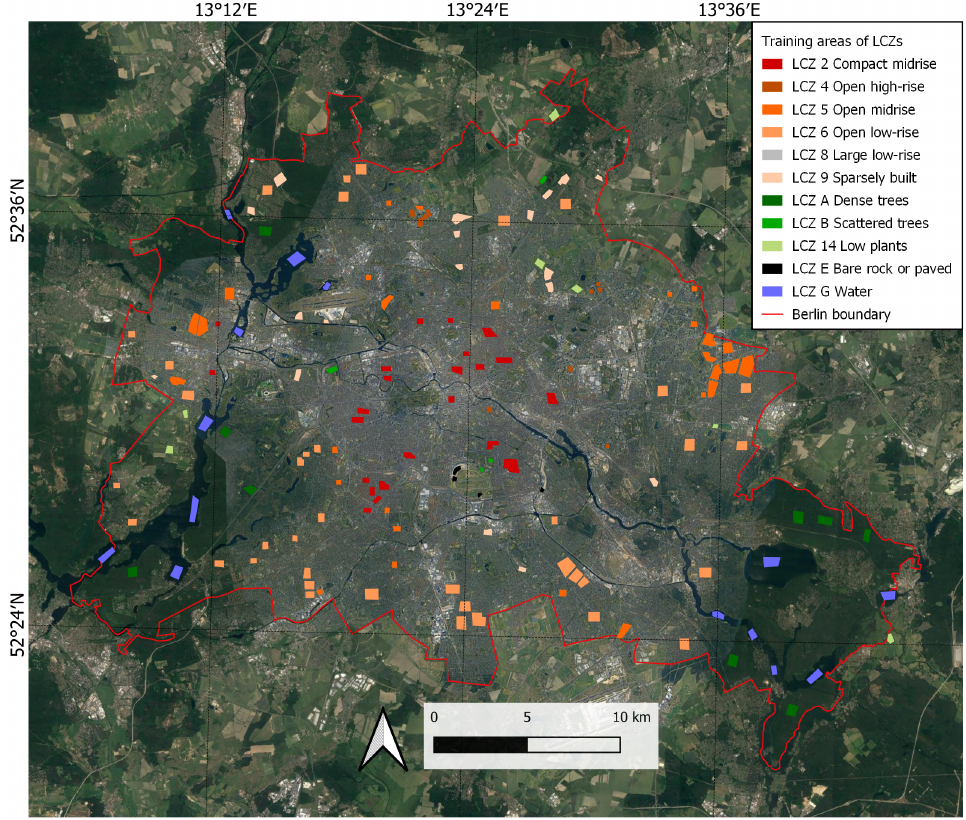
Figure 2. Local climate zones: Berlin’s training areas, see Section 2.5 (Google Earth image in